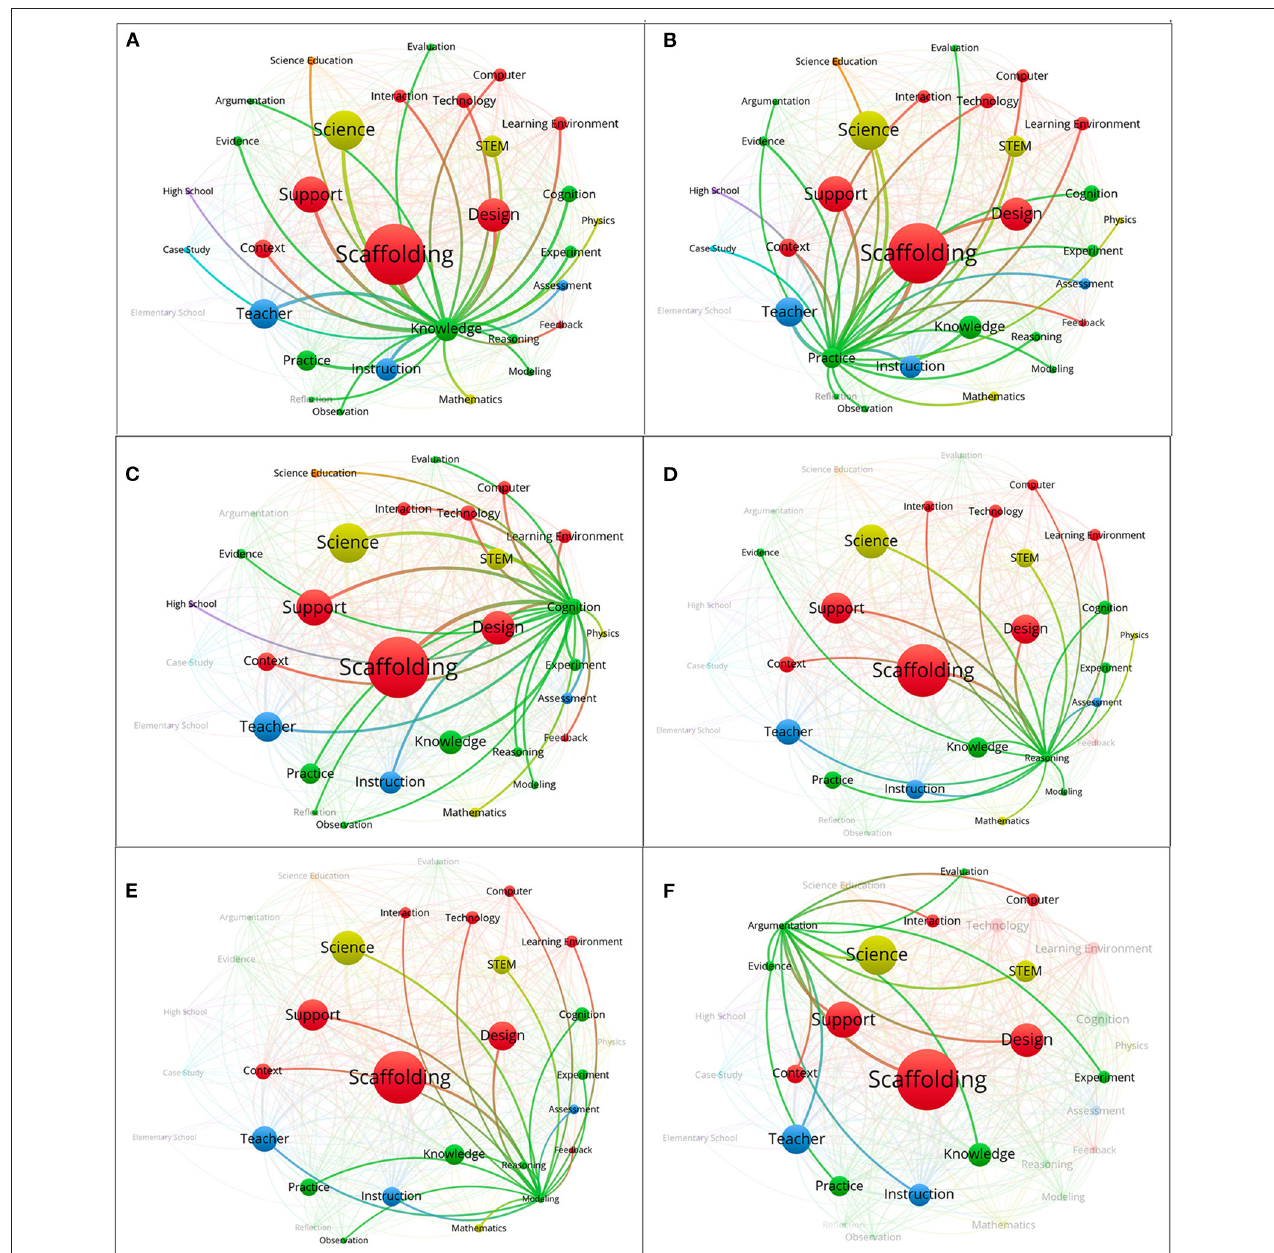
FIGURE 8 | (A) “Knowledge” and other frequently co-word network analysis (keywords = 29). (B) “Practice” and other frequently co-word network analysis (keywords = 29). (C) “Cognition” and other frequently co-word network analysis (keywords = 27). (D) “Reasoning” and other frequently co-word network analysis (keywords = 21). (E) “Modeling” and other frequently co-word network analysis (keywords = 21). (F) “Argumentation” and other frequently co-word network analysis (keywords =